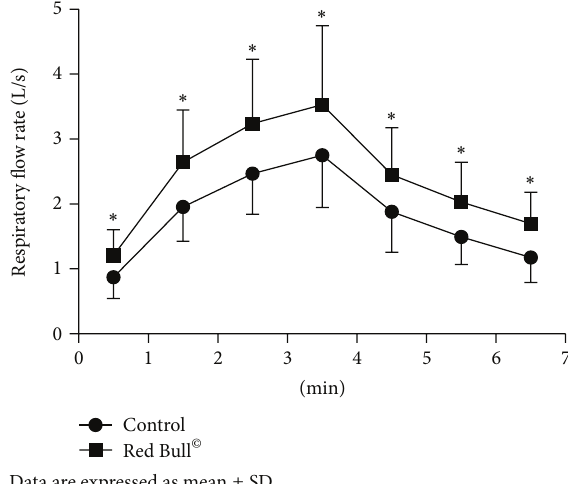
Figure 4: Change of respiratory flow rate (RFR) during 1-minute rest, 3-minute of Harvard Step Test, and 3-minute rest after exercise before and after Red Bull ©